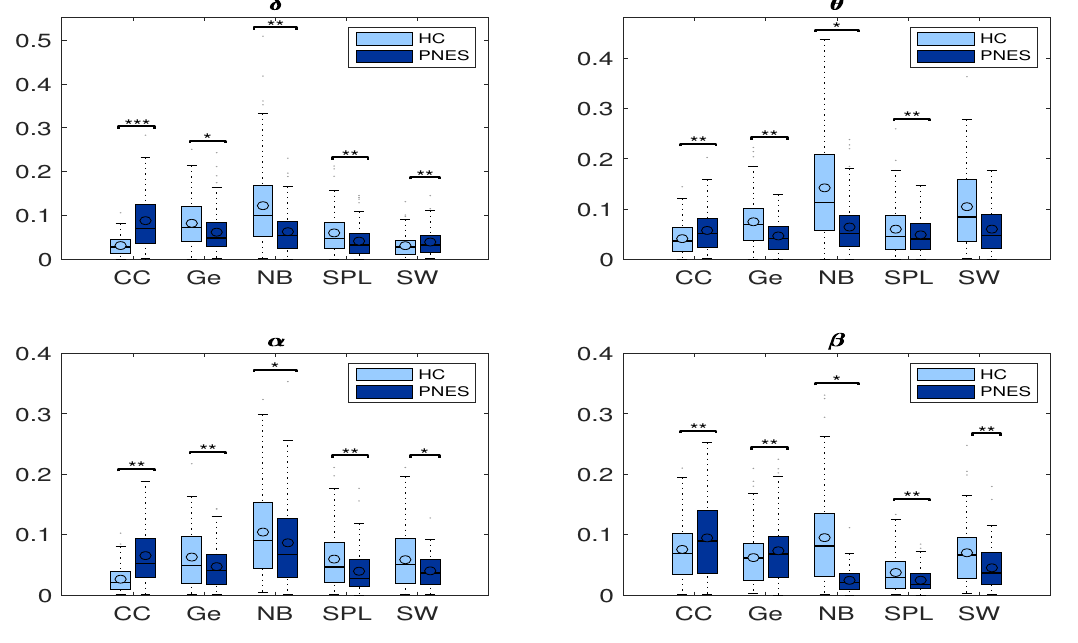
Figure 8. Box plots of network coefficients measured in PNES and HC. Here, we report normalized network coefficients values of: CC , Ge , NB , SPL , and SW in delta , theta , alpha , and beta bands. The horizontal mark within each box represents the median, the edges of the box represent the first and third quartile, and the whiskers extend to the most extreme data points that are not considered outliers, where the symbols ** stand for p < 0.05, and *** for p < 0.001. The PSD measures was computed in PNES and control in the delta, theta, alpha, and beta frequency